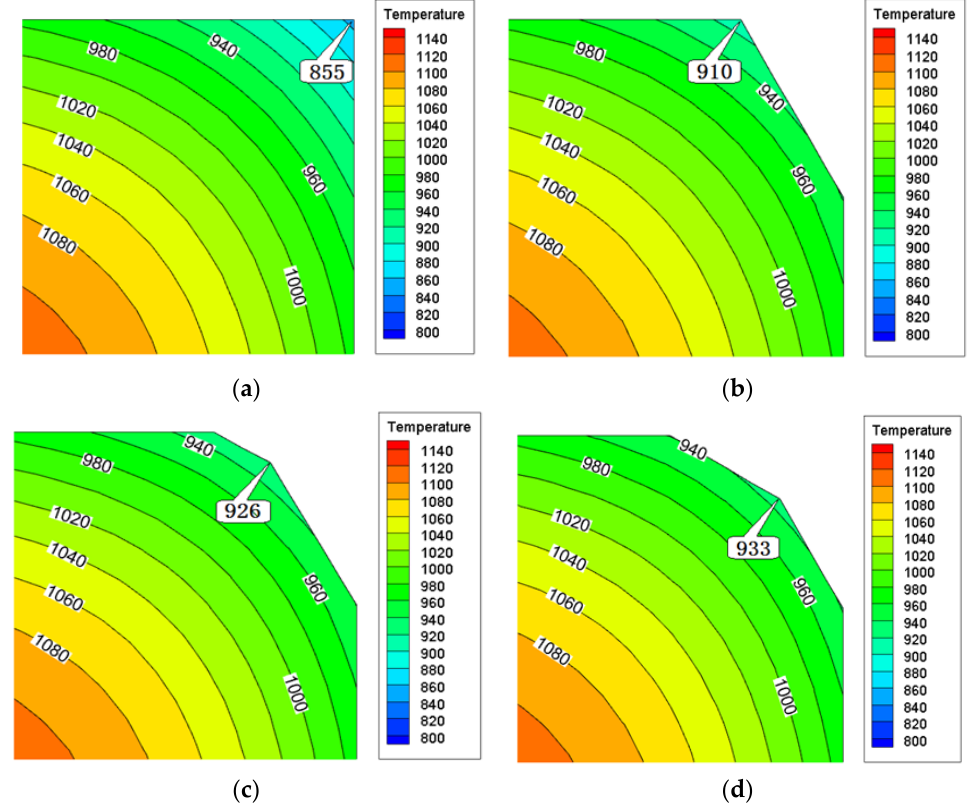
Figure 10. Temperature distribution of slab corners of different shapes. ( a ) Right-angle slab; ( b ) one- chamfered slab; ( c ) small two-chamfered slab; ( d ) large two-chamfered slab.